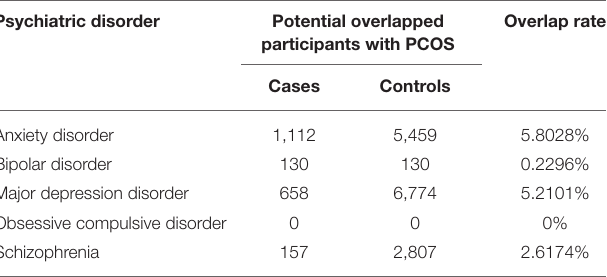
TABLE 2 | Participant overlap between polycystic ovary syndrome and each psychiatric